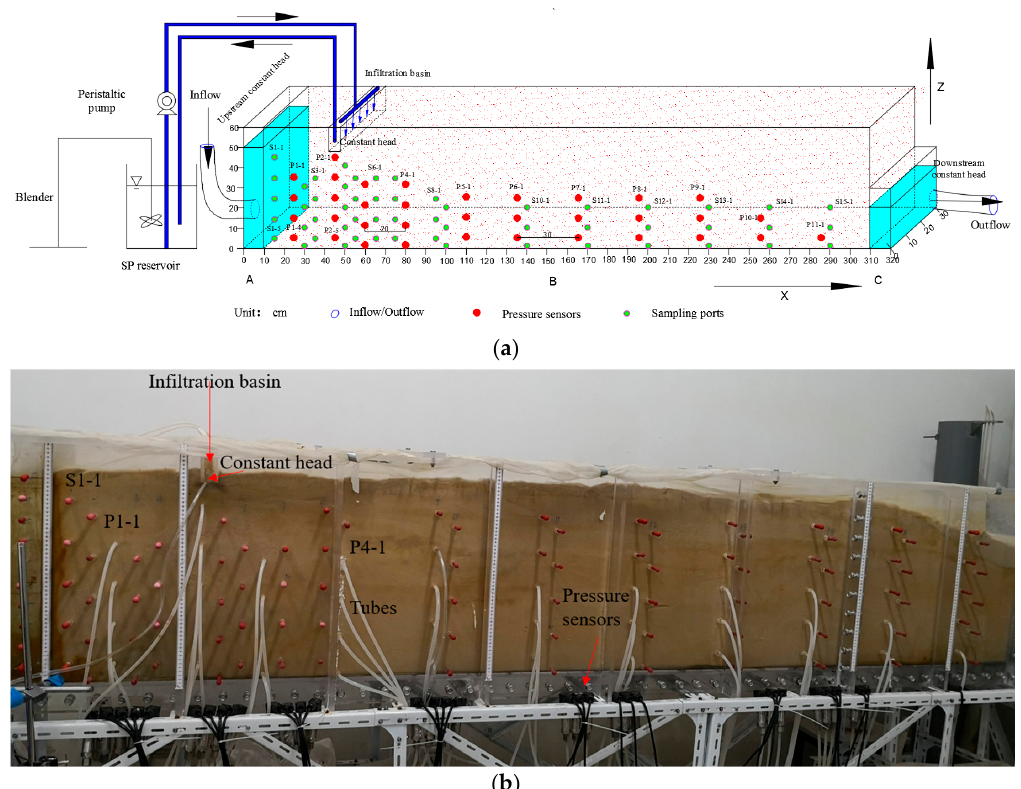
Figure 1. Illustration of the experimental apparatus. ( a ) Sketch map. A and C represent upstream and downstream constant heads respectively (upstream 50 cm and downstream 20 cm); B is the sand aquifer. ( b ) Physical model. An infiltration basin is located 45 cm downstream of the upstream constant head with water level kept at 52 cm. The experiment is divided into three stages: (1) self-filtration stage (no water infiltration); (2) clean water infiltration stage; and (3) stormwater infiltration stage. The hydraulic conductivity ( K ) was measured during the self-filtration stage; the concentrations of SP were measured during the stormwater infiltration stage; and the hydraulic heads were monitored by pressure sensors and logged in a computer.